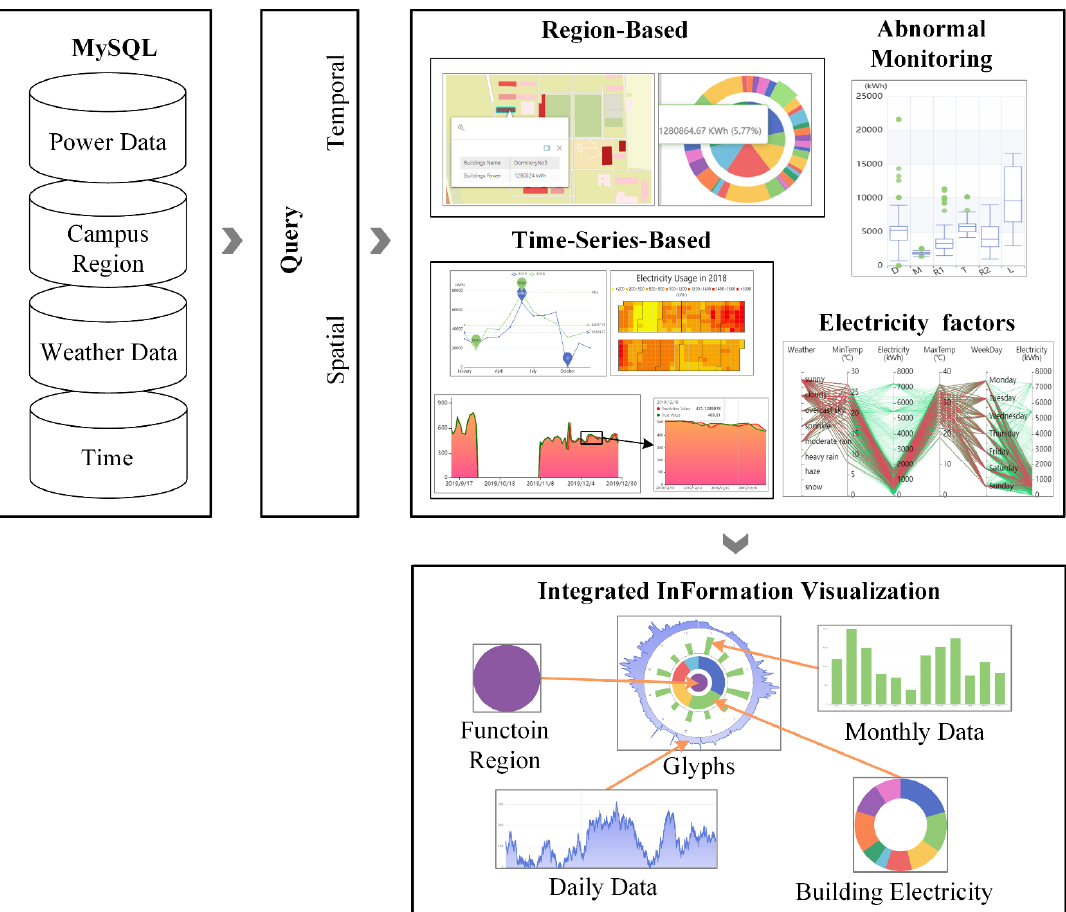
Figure 6. System architecture.